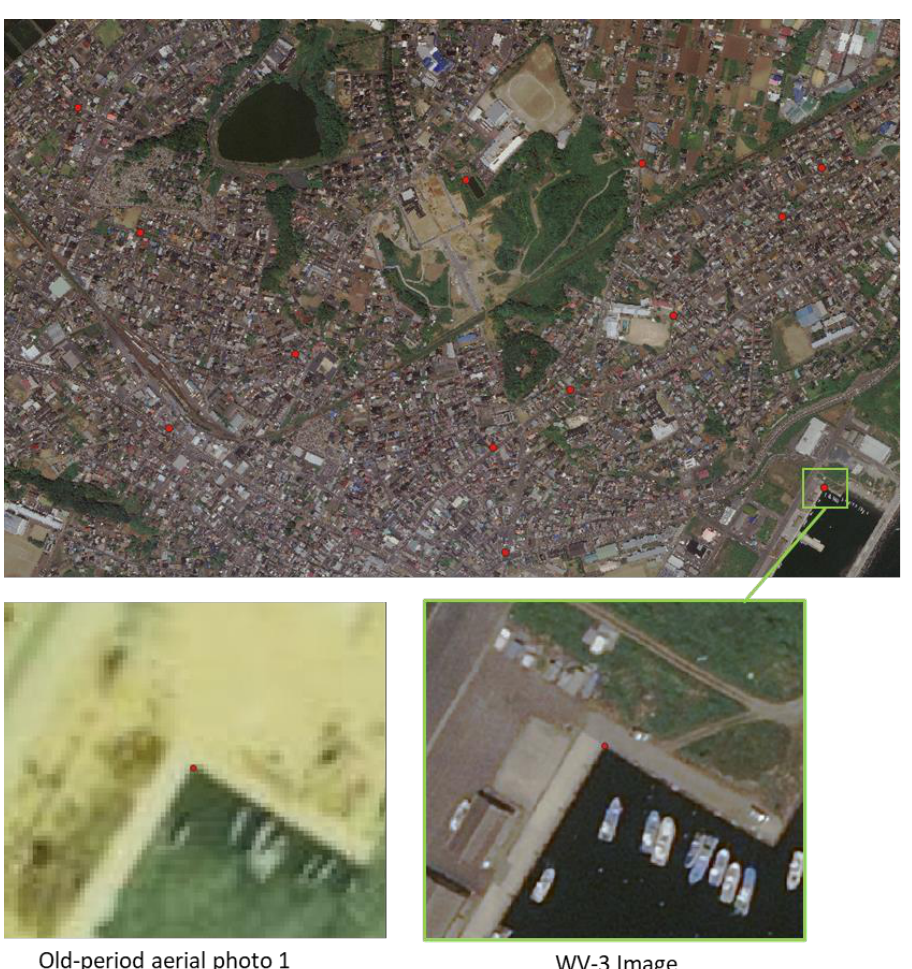
Figure 10. Thirteen GCPs (red points) manually acquired from WV-3 image in Hitachinaka area ( top ). Enlarged images of old-period aerial photo 1 and WV-3 image are shown with one GCP acquired from each image (bottom).